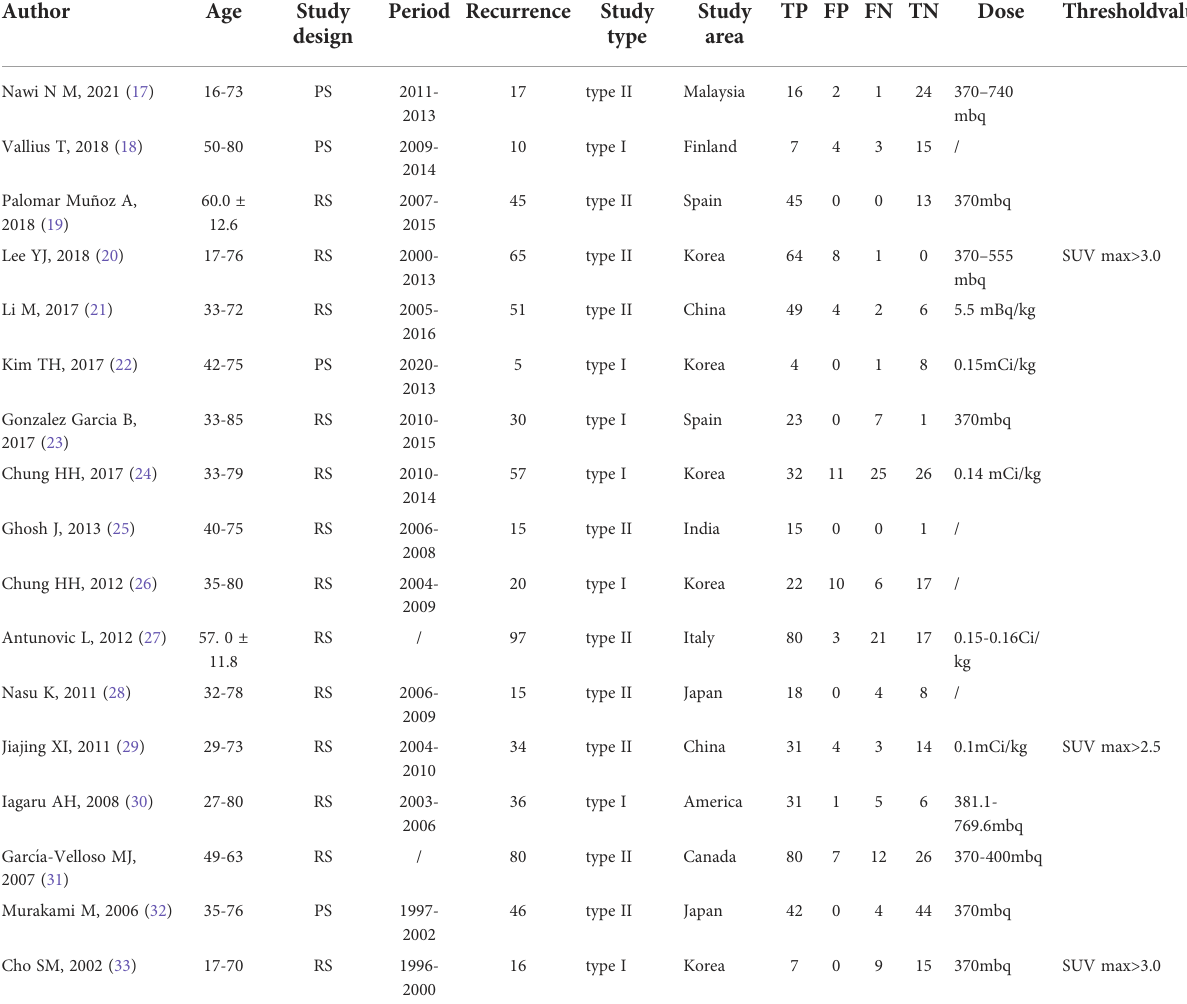
TABLE 1 Basic information of the literature on 18 F-FDG PET/CT for the diagnosis of epithelial ovarian cancer recurrence.